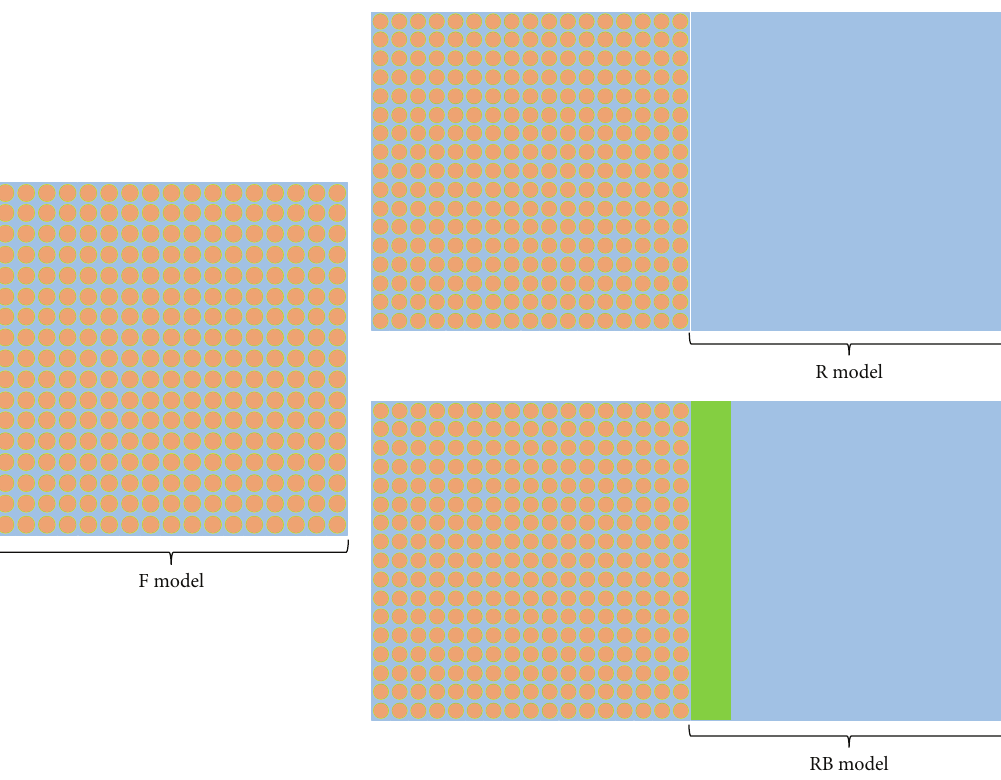
Figure 6: Unit models for DIMPLE S06 two-step